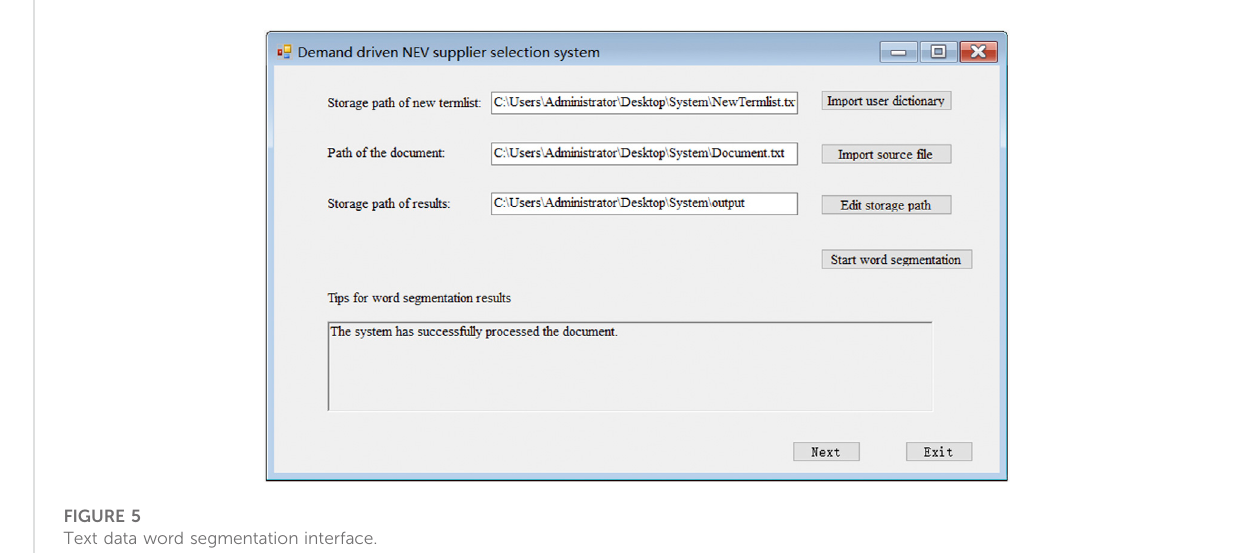
FIGURE 5 Text data word segmentation interface.